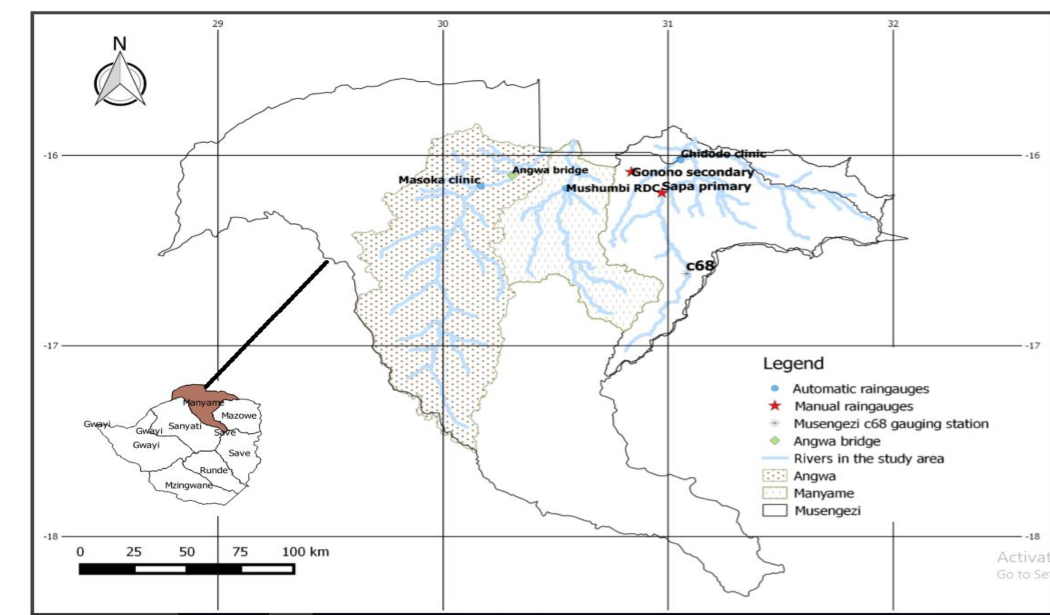
Figure 1. The Mbire District in Lower Guruve showing manual and automatic rain gauge